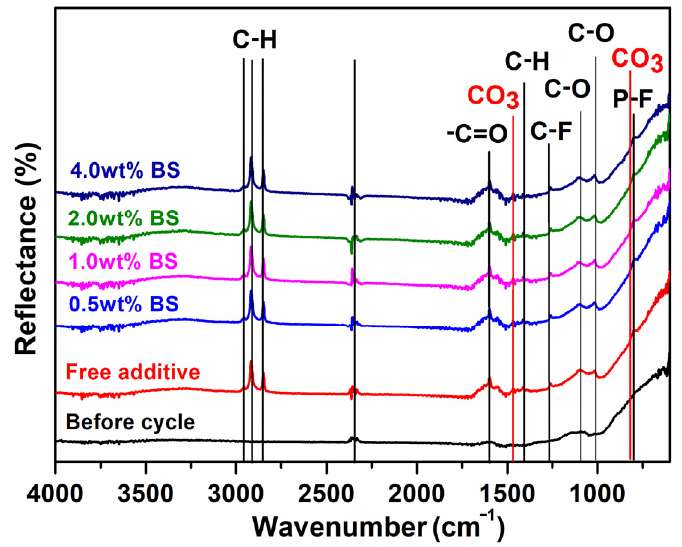
Figure 6. ATR-FTIR spectra of LTO, before and after cycling, in different concentrations of BS contents at the 0.2 C-rate for 50 cycles.